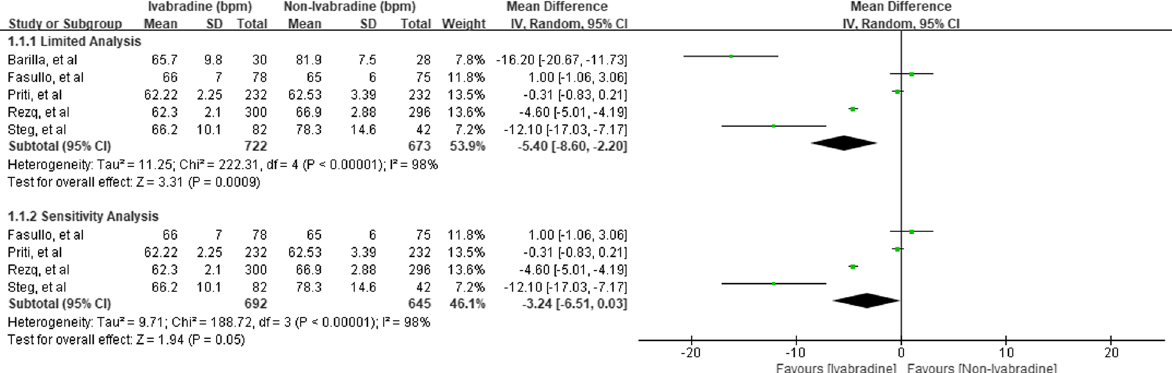
Fig. 2 Effect of Ivabradine on Heart Rate